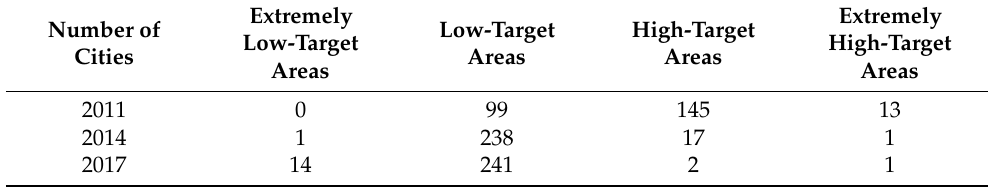
Figure 2. Spatial and temporal distribution of ULGUE in China. ( a ) Spatial distribution of ULGUE in 2011; ( b ) spatial distribution of ULGUE in 2014; ( c ) spatial distribution of ULGUE in 2017. Table 2. Spatial and temporal distribution of ULGUE in China. Table 3. Spatial and temporal distribution of economic growth target in